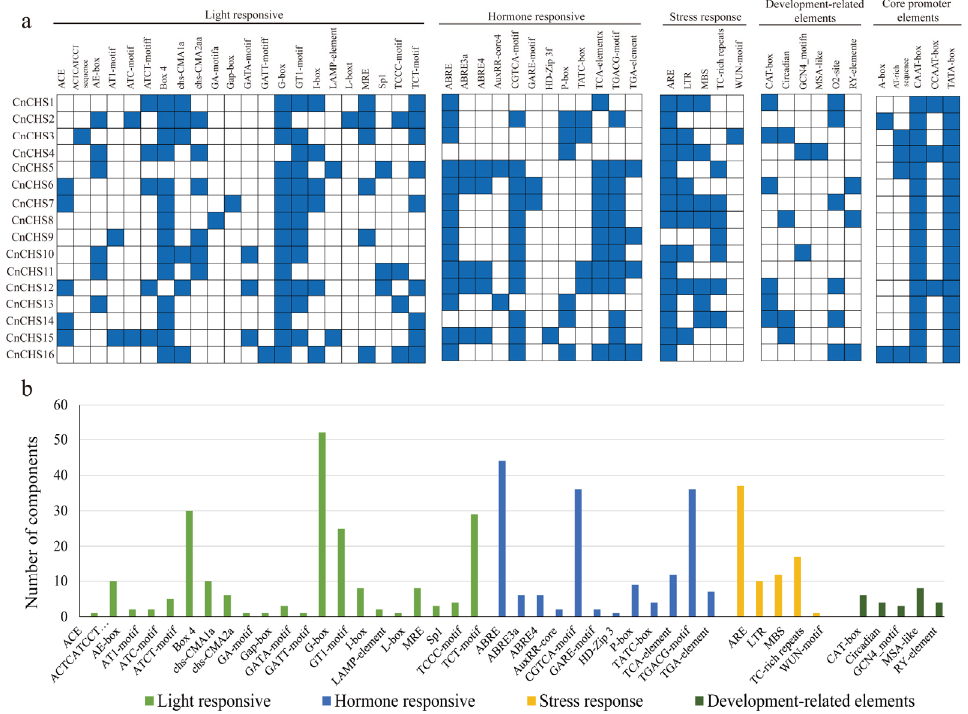
Figure 5. Cis -element analysis in the promoter of CnCHS genes. ( a ) The black blocks at the top show five different types of cis -acting elements, and the horizontal axis represents the different cis -acting elements. ( b ) Numbers of four different types of cis -acting elements.